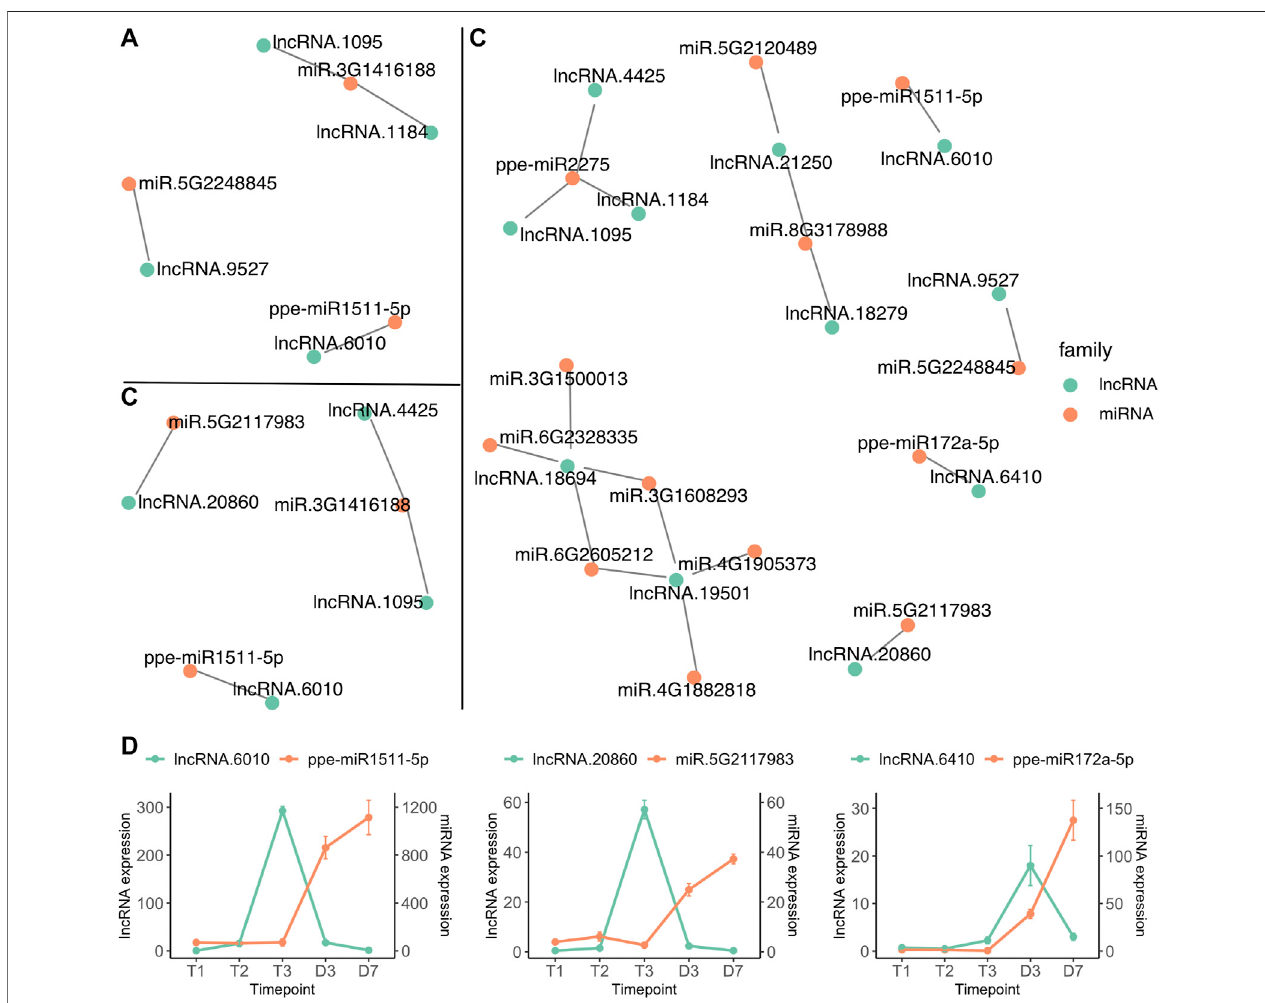
FIGURE 7 | lncRNA (green) and miRNA (red) interaction networks of differentially expressed lncRNAs from T1 vs. T2 (A) , T2 vs. T3 (B) and T3 vs. D3 (C) (D) The expression pro fi les (mean ± SE) of microRNA and lncRNA pairs that are both differentially expressed between T3 and D3.